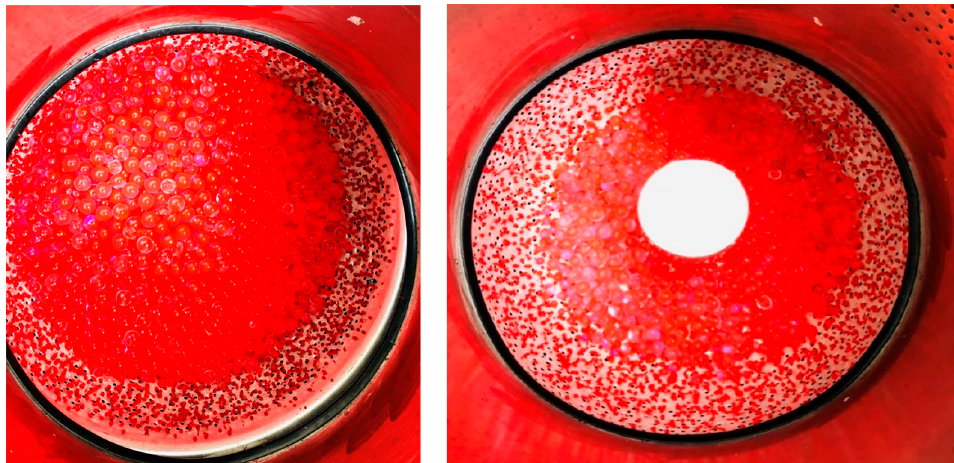
Figure 14. Images of the drying Orbeez in the drying chamber. The left-hand image shows the original chamber, and the right-hand image shows the modified chamber with better air distribution.